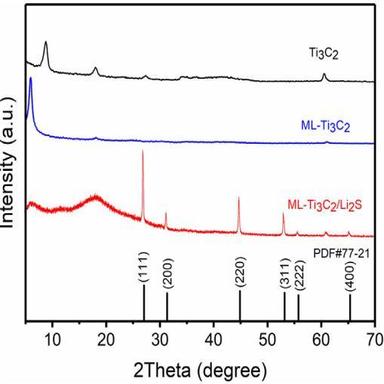
XRD patterns of Ti3C2, ML-Ti3C2 and ML-Ti3C2/Li2S.